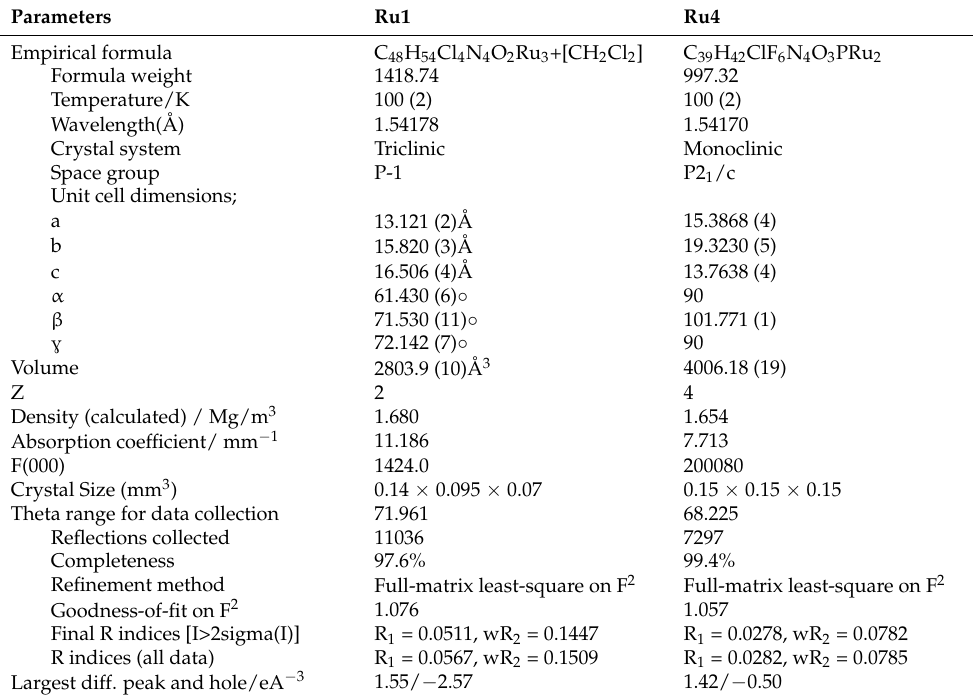
Table 1. Summary of crystallographic parameters and refinement